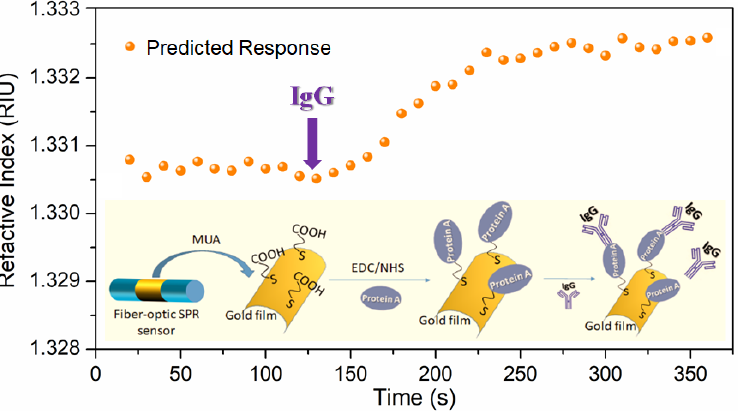
Figure 6. Predicted response of IgG samples flowing through the sensing surface by using BP neural network. Inset: Functionalization process on gold film of FO-SPR component.